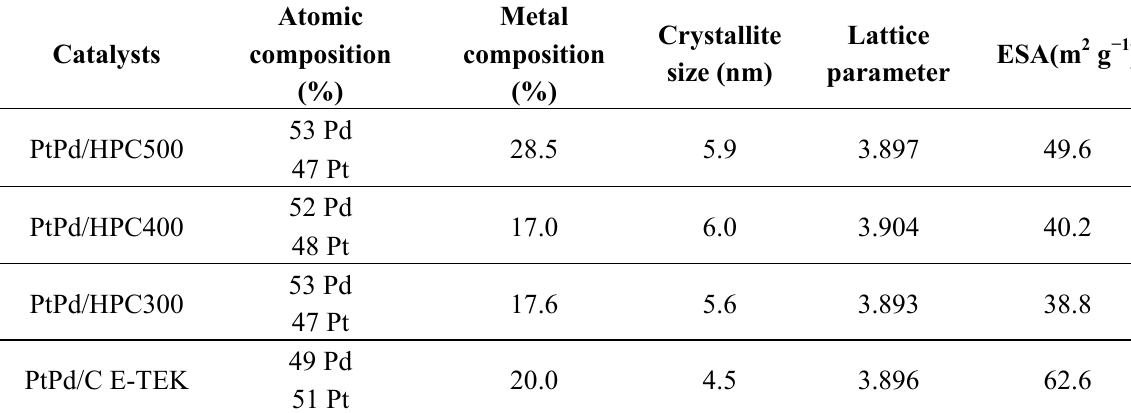
Table 1. EDS, XRD and ESA results for PtPd/HPCs and commercial PtPd/C E-TEK.